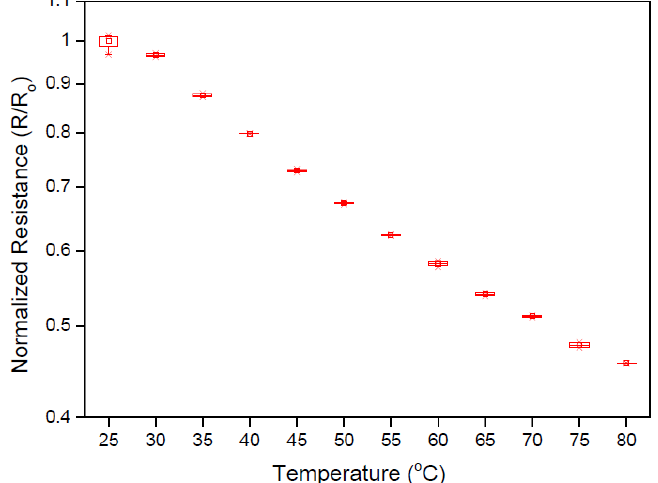
Figure 4. Resistance-temperature relation for ITO/CuTsPc solution/ITO